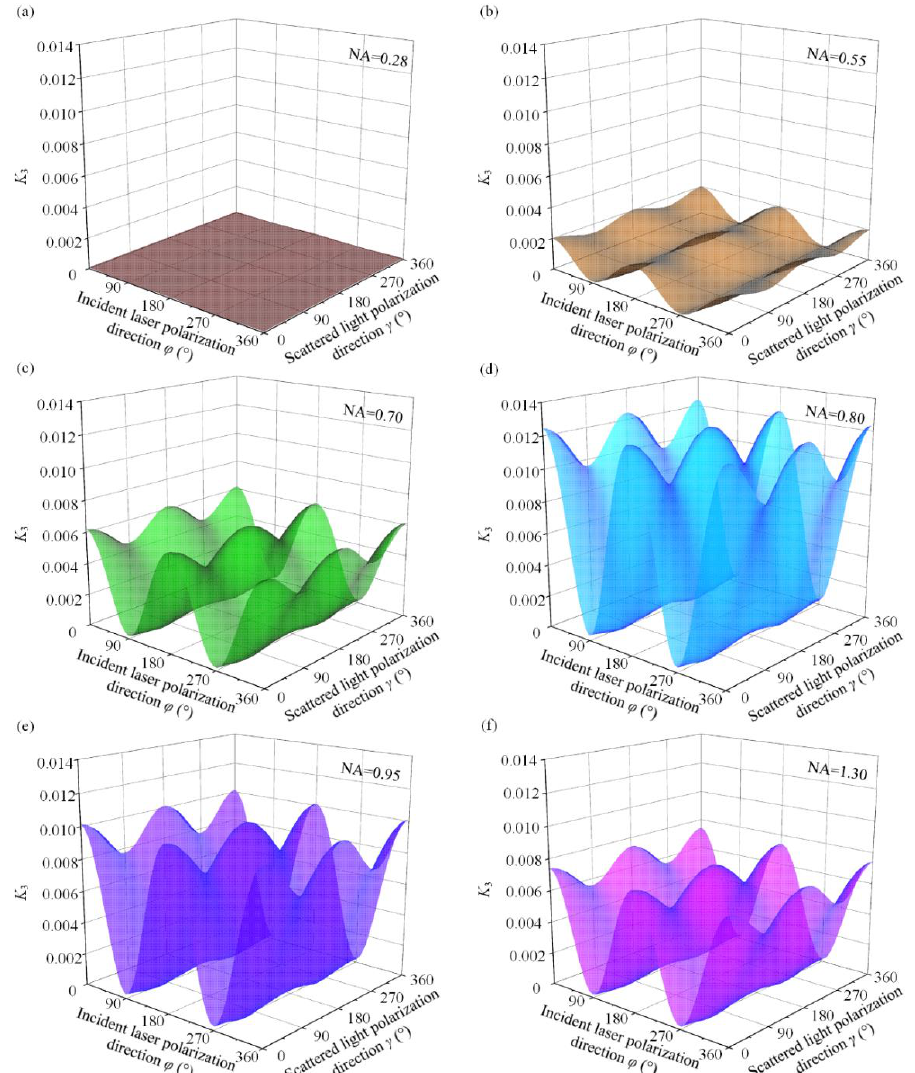
Figure 6. Ratio of the coefficient of the principal stress difference to that of the principal stress sum for different NA ( K 3 ): ( a ) NA = 0.28; ( b ) NA = 0.55; ( c ) NA = 0.70; ( d ) NA = 0.80; ( e ) NA = 0.95; ( f ) NA = 1.30.